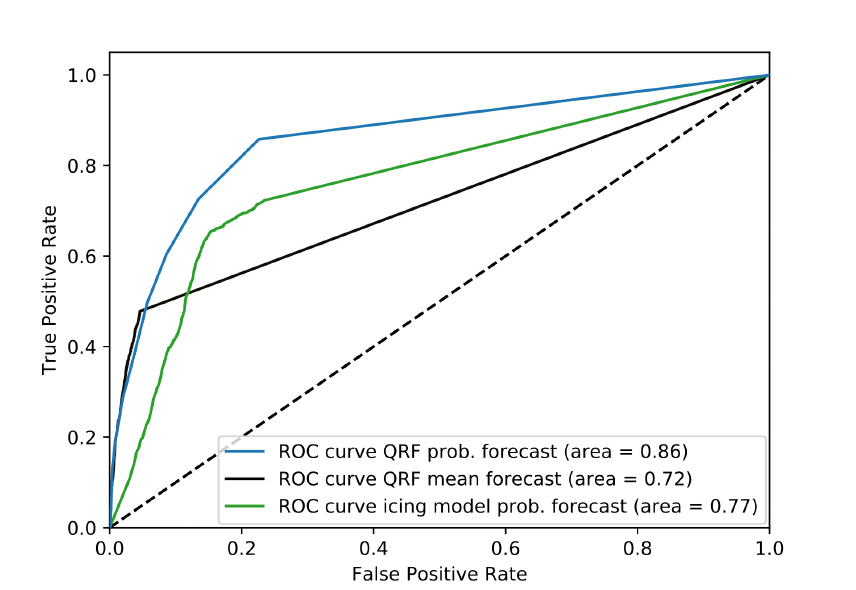
Figure 13. Receiver operating characteristics (ROC) curves for forecasting the probability of produc- tion loss > 0.5 MW for the splitting option, including station name, deterministically and probabilistic, and the icing model ensemble in Molinder et al.